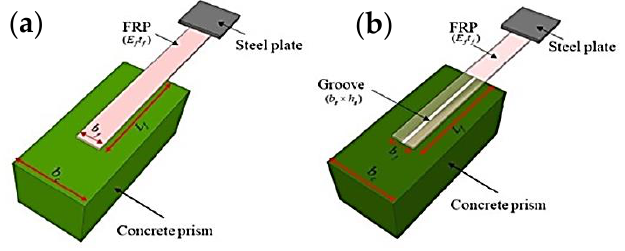
Figure 1. Single-lap shear test: ( a ) FRP externally bonded on concrete; ( b ) FRP externally bonded on the grooves of concrete (adapted with permission from Su et al. [58]).